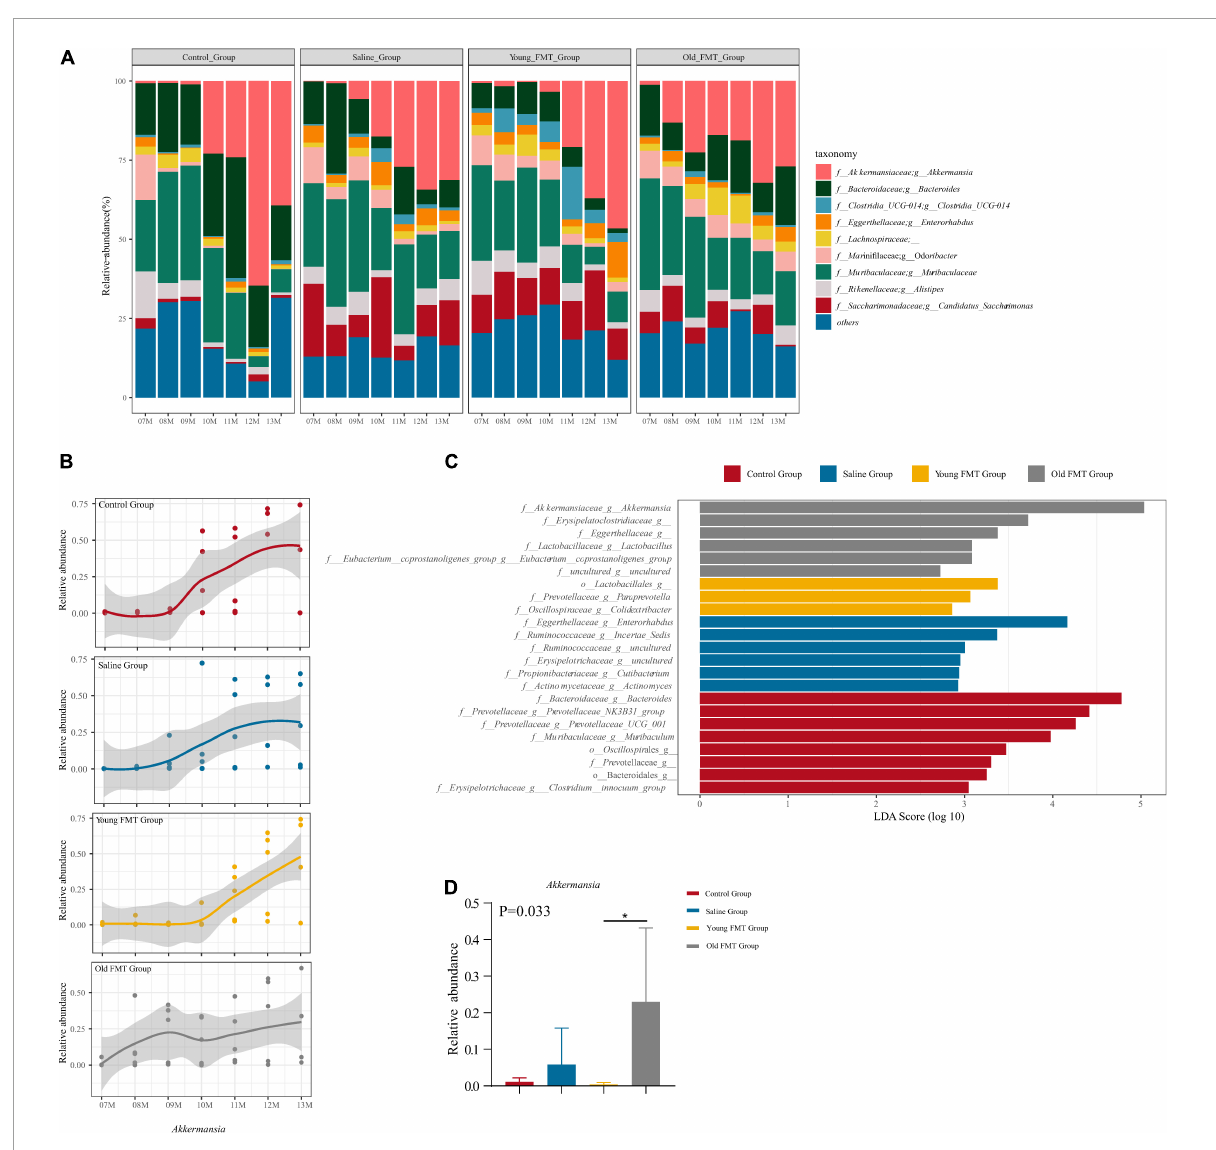
FIGURE5 Akkermansia is the potential biomarker of aging. (A) The stacked histogram of the top 10 most abundant microbiota at genus level in relative abundance from 7 to 13 ◦ months old sequencing mice sample within the group. (B) The Nonlinear regression (95% confidence intervals) of the relative abundance of Akkermansia from 7 to 13 ◦ months old within group. The scatters represented the relative abundance of Akkermansia in samples. (C) The LDA score of different taxa obtained by the LEfSe analysis within 4 groups at 9 ◦ months old (Kruskal-Wallis H test, P < 0.05, LDA ≥ 3.0). (D) The relative abundance of Akkermansia within four groups at 9 ◦ months old (Kruskal-Wallis H test, P < 0.05*). Red: Control group; Blue: Saline group; Yellow: Young FMT group; Gray: Old FMT group; 7–11 ◦ months old: n = 5 per group; 12 ◦ months old: n = 3